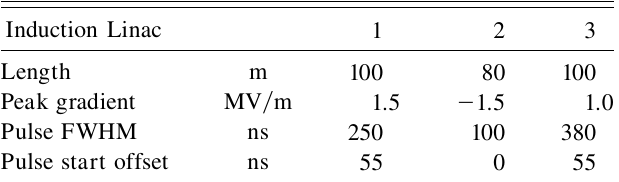
TABLE VII. Properties of the induction linacs used in fea- sibility study II.